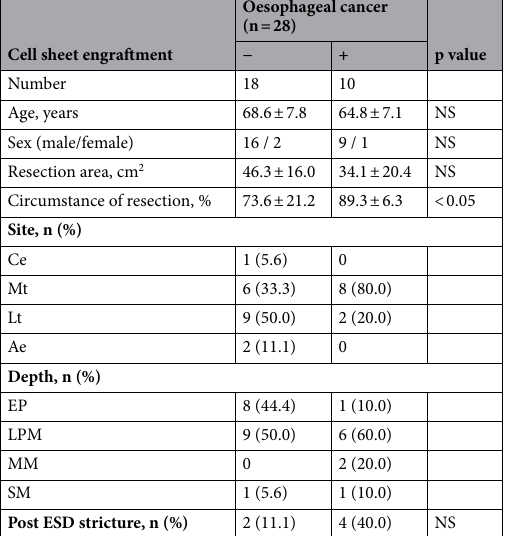
Table 1. Patient characteristics. ESD endoscopic submucosal dissection, Ce cervical oesophagus, Mt middle thoracic oesophagus, Lt lower thoracic oesophagus, Ae abdominal oesophagus epithelium, LPM lamina propria mucosa, MM muscularis mucosae, SM submucosa.